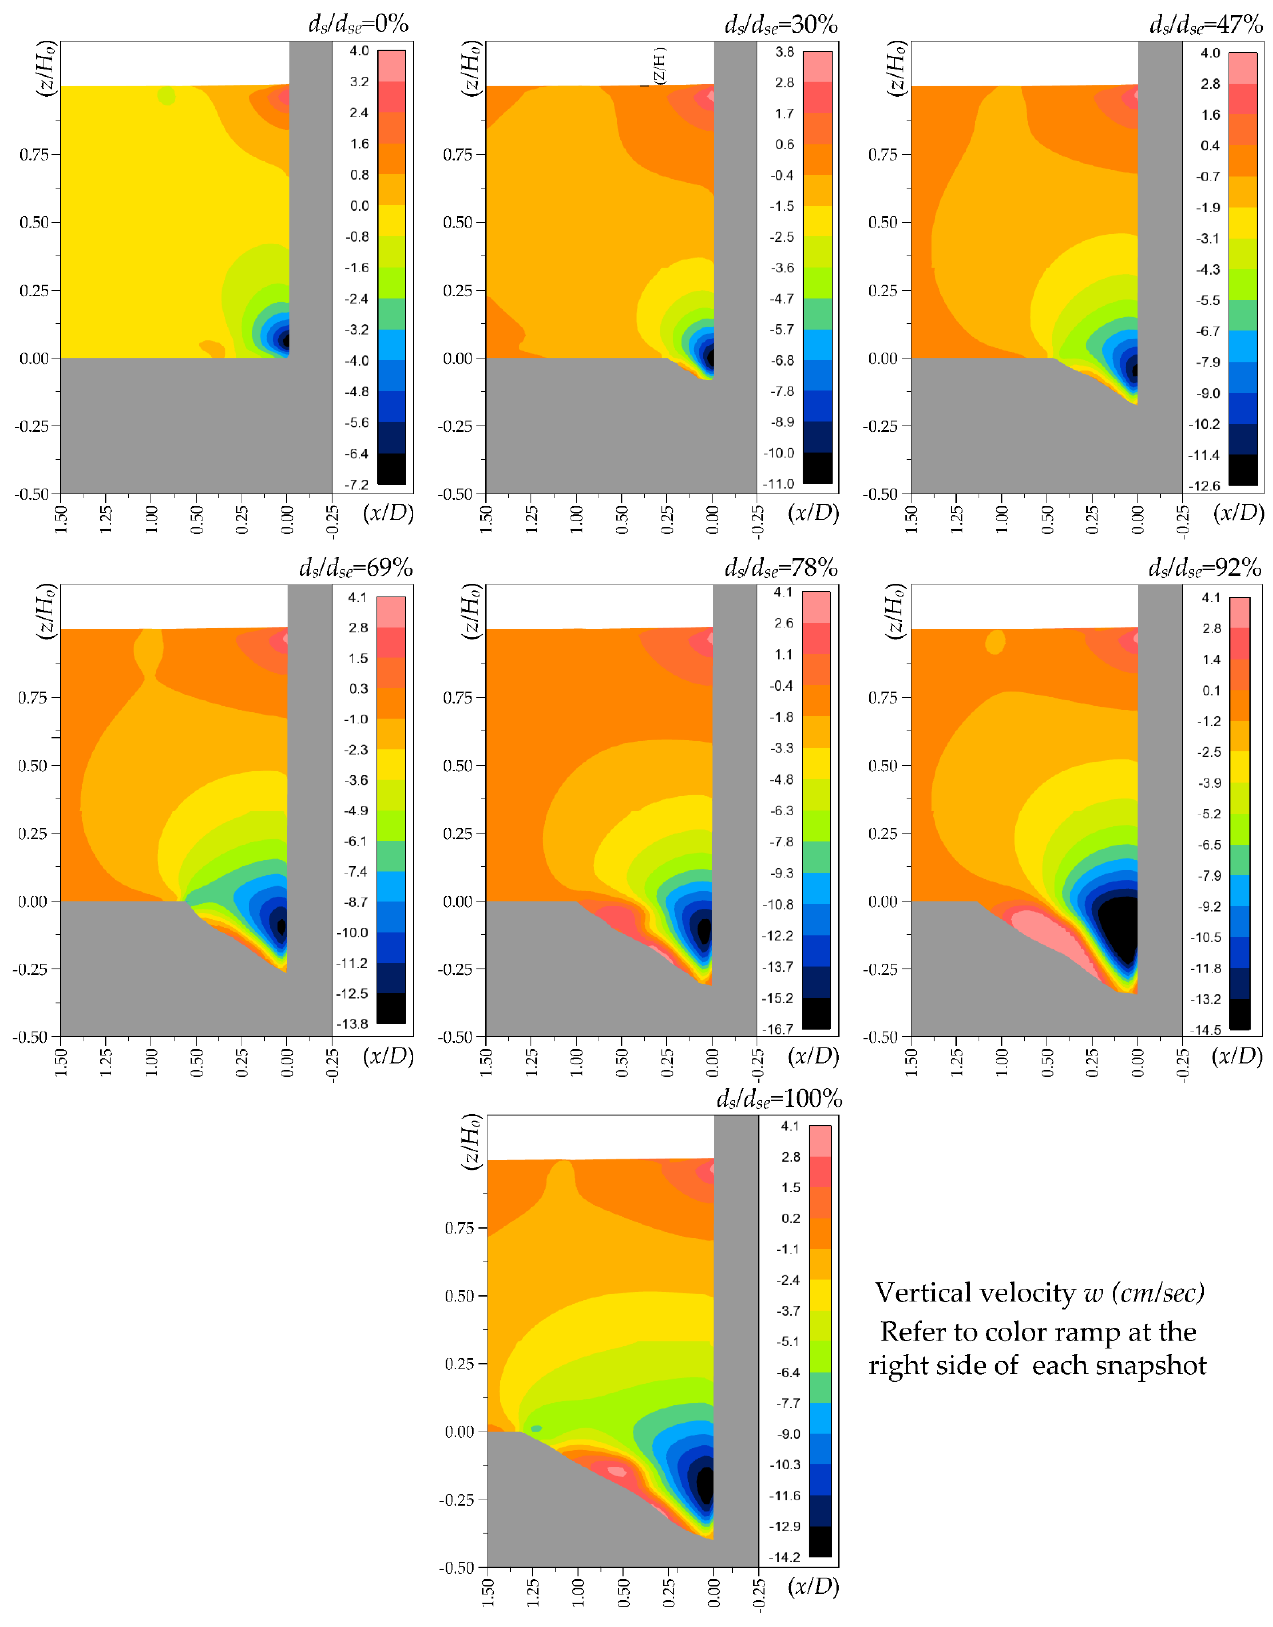
Figure 12. Vertical velocity distribution at the plane of symmetry.